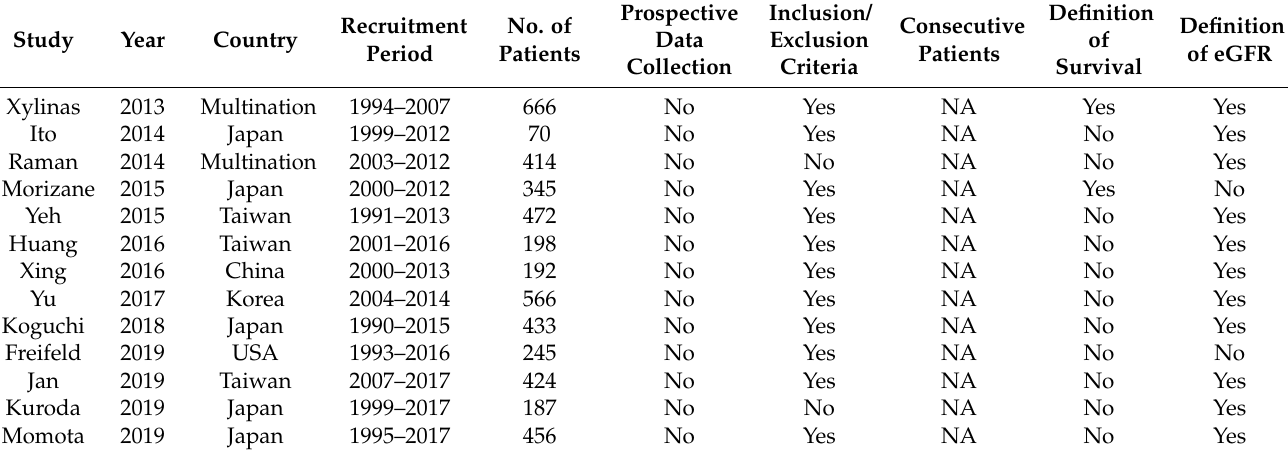
Table 1. Main characteristics of the eligible studies.